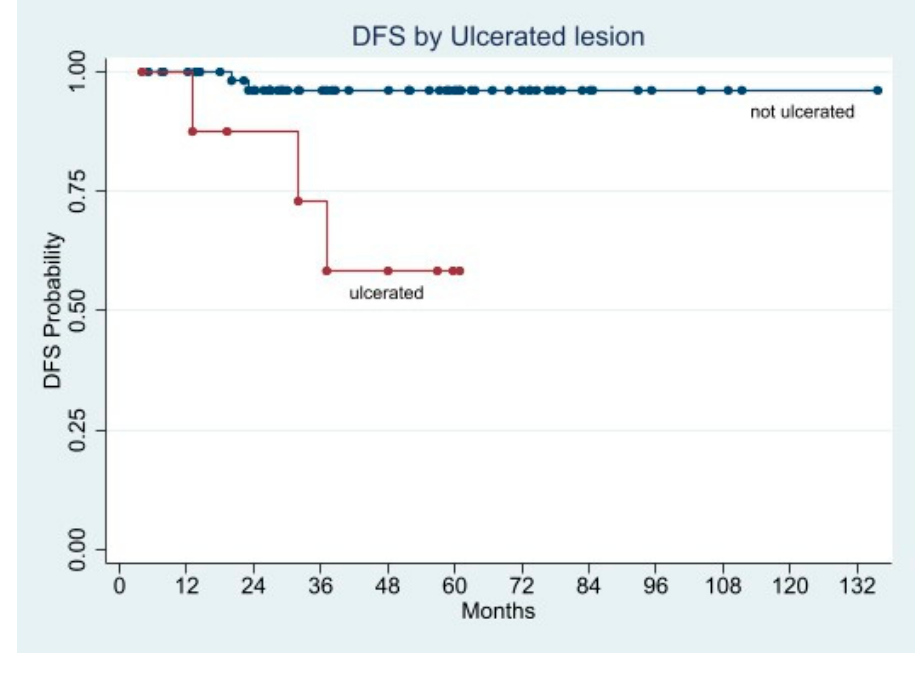
Cancers 2021 , 13 , 4351 Figure 12. Disease Free Survival by Ulcerated lesion. Figure 12. Disease Free Survival by Ulcerated lesion.